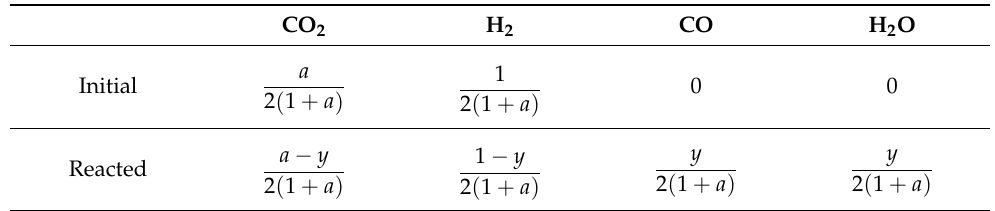
Table 1. Mole fractions in the gas stream with a CO 2 to H 2 ratio of a : 1 in the initial mixture and after an arbitrary amount of the educts